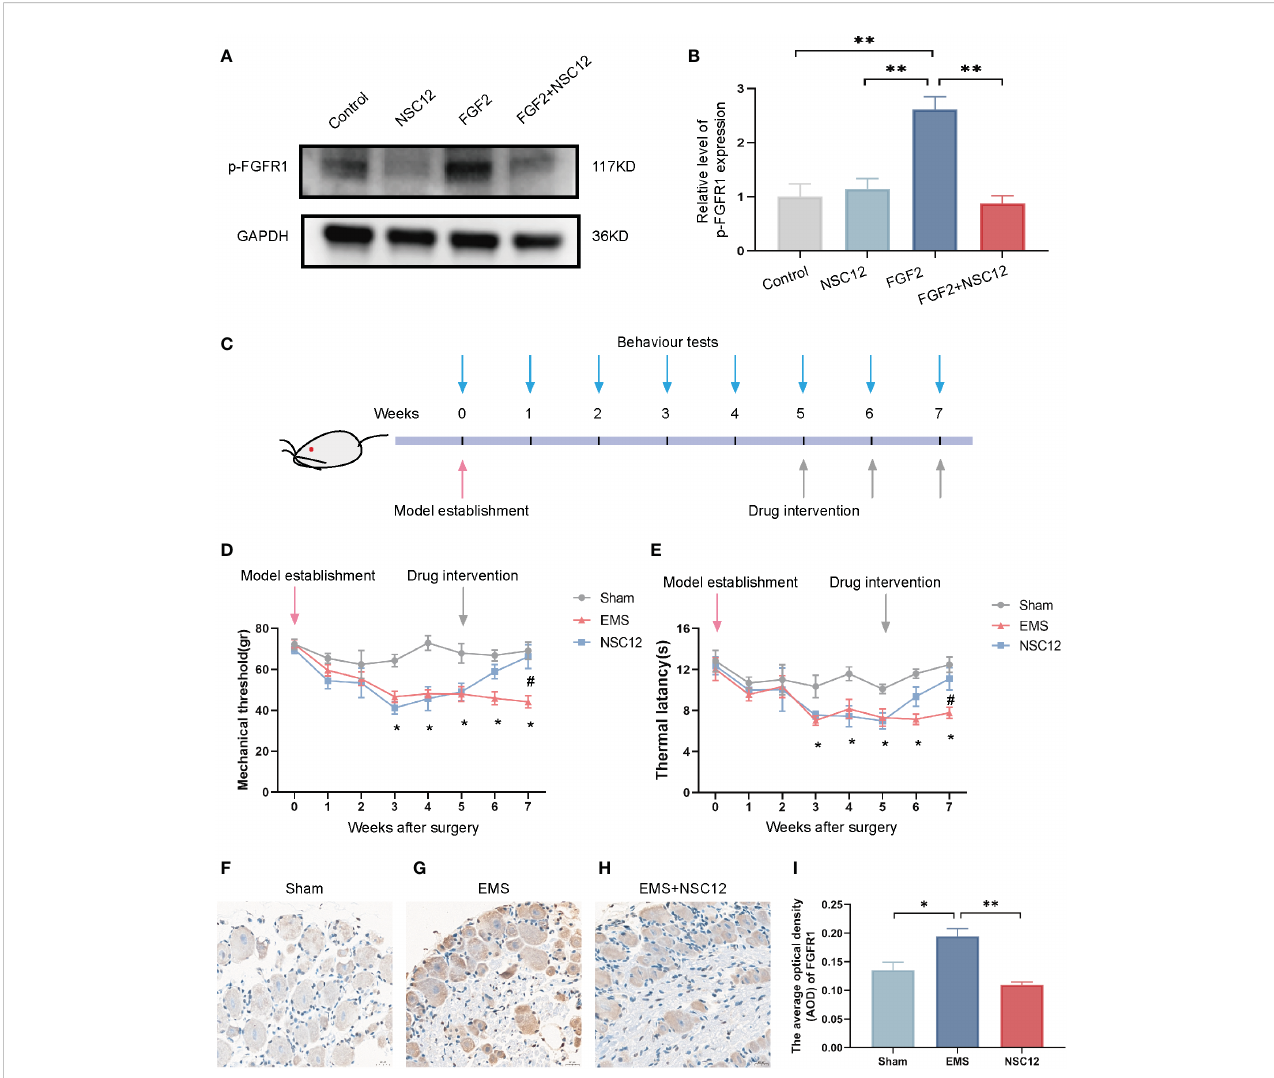
FIGURE 7 NSC12 relieves endometriosis-induced hyperalgesia in vivo . (A) Protein expression of p-FGFR1in DRG cells after different interventions. (B) Relative level of p-FGFR1 expression (n = 3 in each group). (C) Schematic of animal intervention. (D) Mechanical threshold after different interventions (n = 6 in each group). (E) Thermal latency after different interventions (n = 6 in each group). (F – H) The Representative images of p-FGFR1 staining in DRG tissue, 400×, bar = 20 m m. I The Relative expression of p-FGFR1 in DRG tissues different intervention group (n = 6, 6, 5). Sham: sham operation group, EMS, endometriosis model; NSC12, endometriosis model establishment and NSC12 intervention. * P < 0.05, ** P <